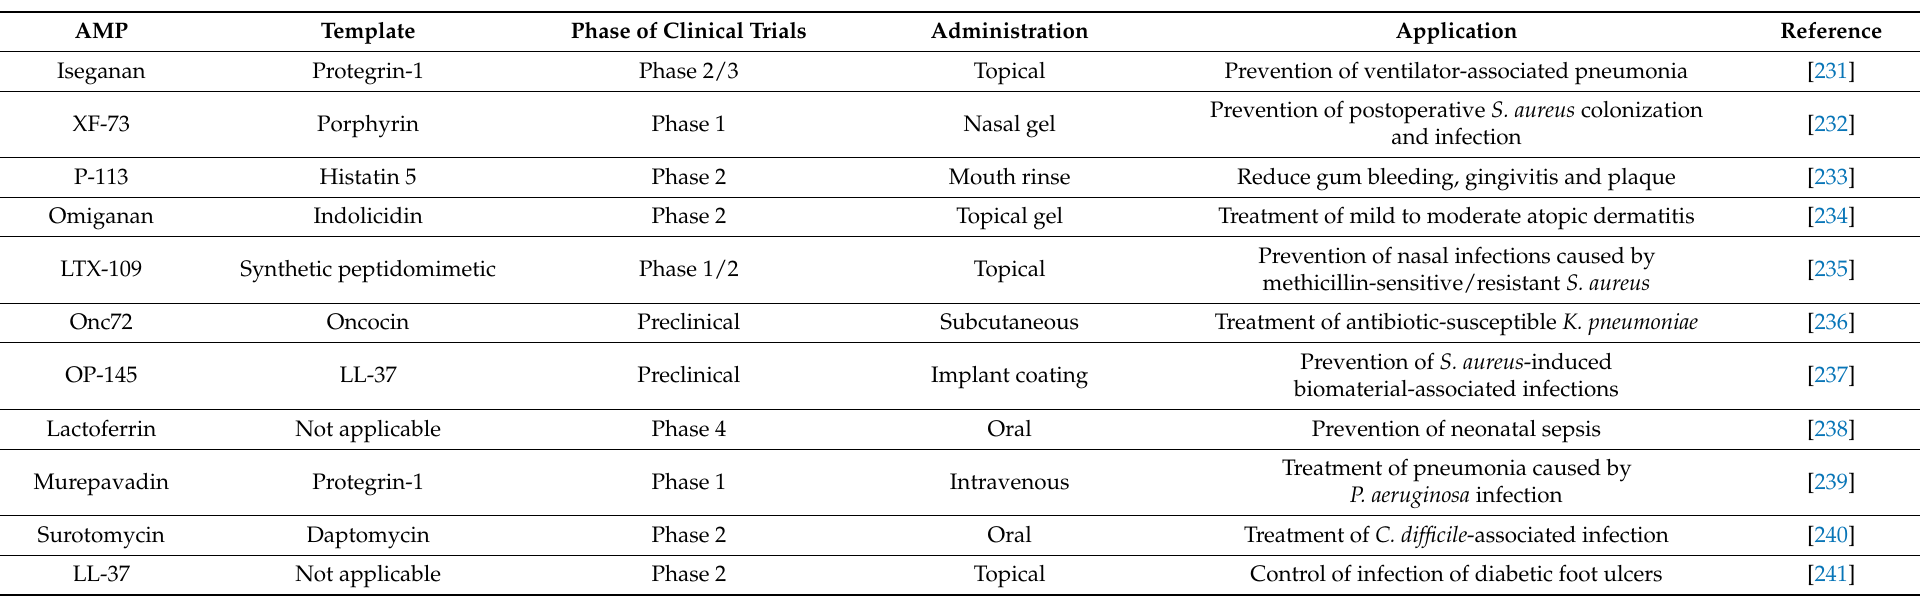
Table 2. AMPs in clinical or preclinical